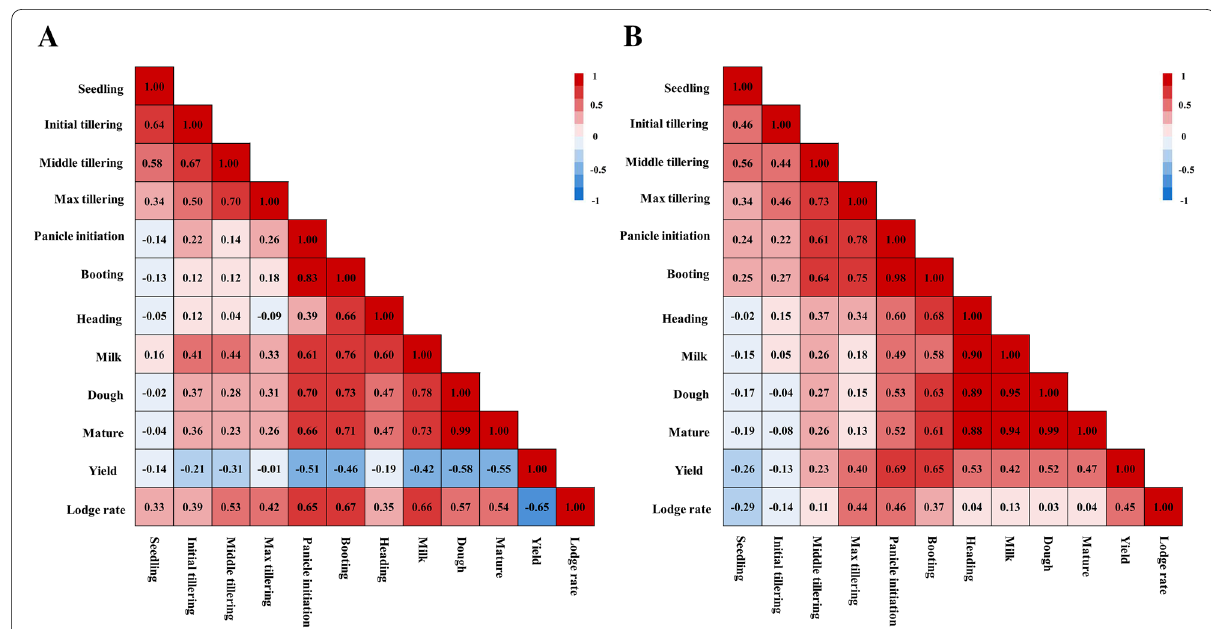
Fig. 3 Pearson correlation results for rice plant height, yield, and lodging result in different growth stages. A Experiment results in 2019. B Experiment results in 2020. The lodging rate is the lodging percentage in the field. The blue blocks represent negative correlations, and the red blocks represent positive